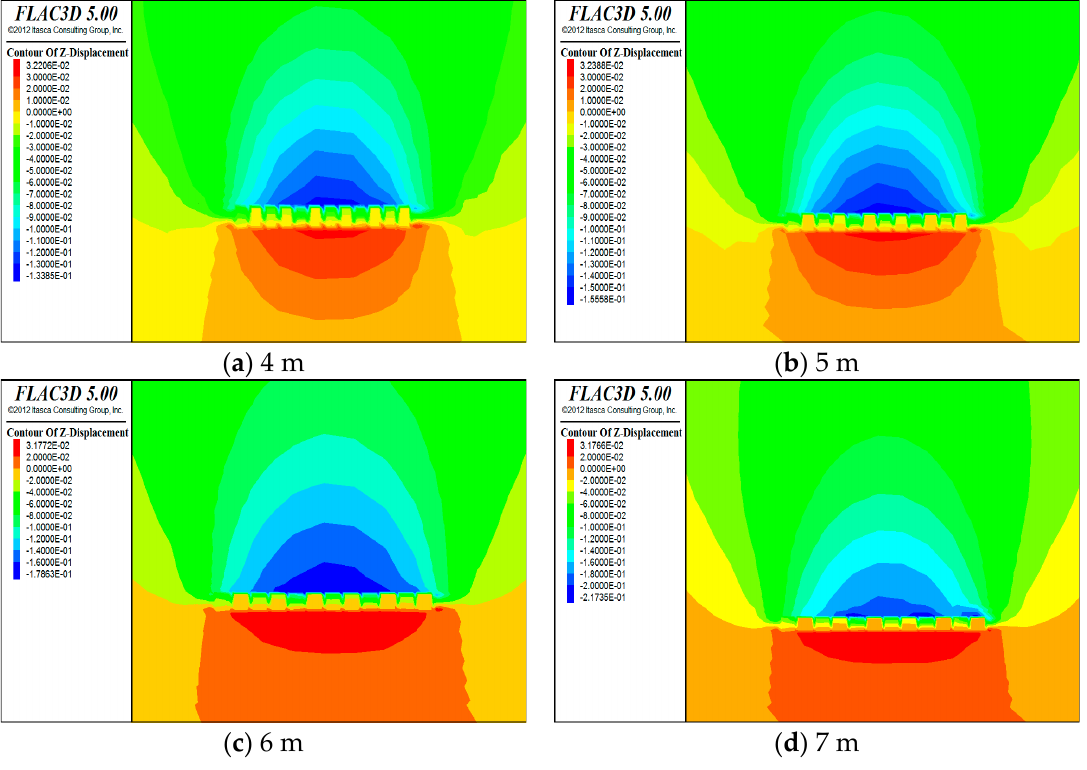
Figure 12. Vertical displacement cloud for (a) 4 m, (b) 5 m, (c) 6 m, and (d) 7 m.